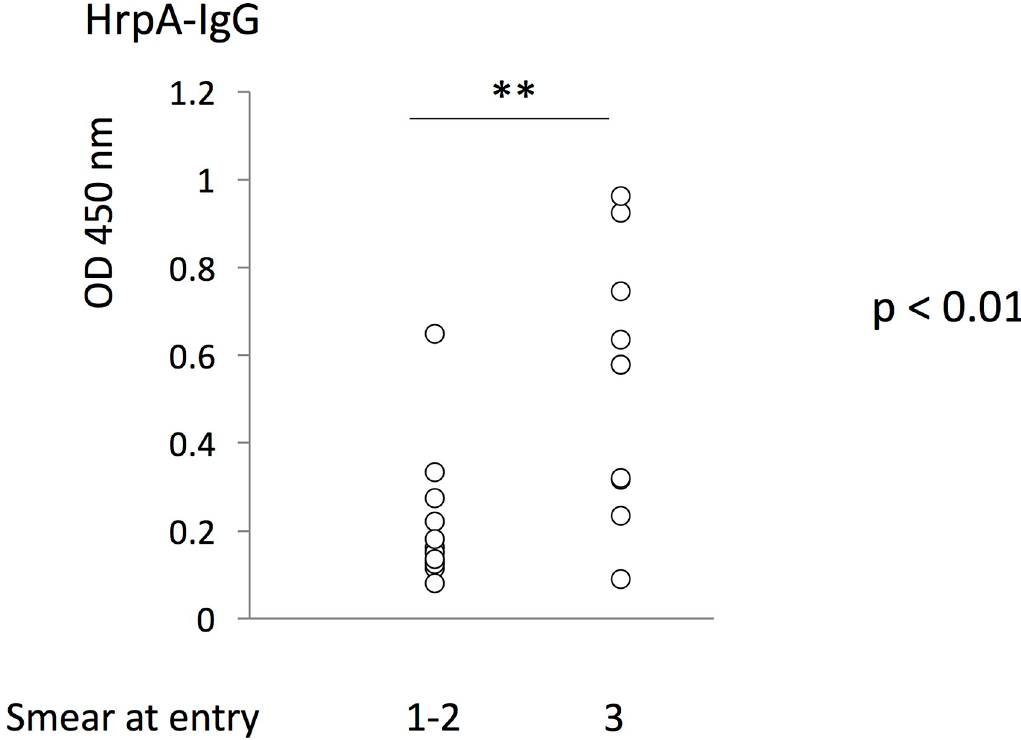
Fig 3. The levels of serum IgG against HrpA before treatment in “Smear at entry”. The levels of serum IgG against HrpA before treatment were compared to the severity in “Smear at entry” sub-grouped between 1+, 2+ and 3+. HrpA-IgG levels before treatment were found to have a positive relationship with “smear at entry” scores. �� : p < 0.01.